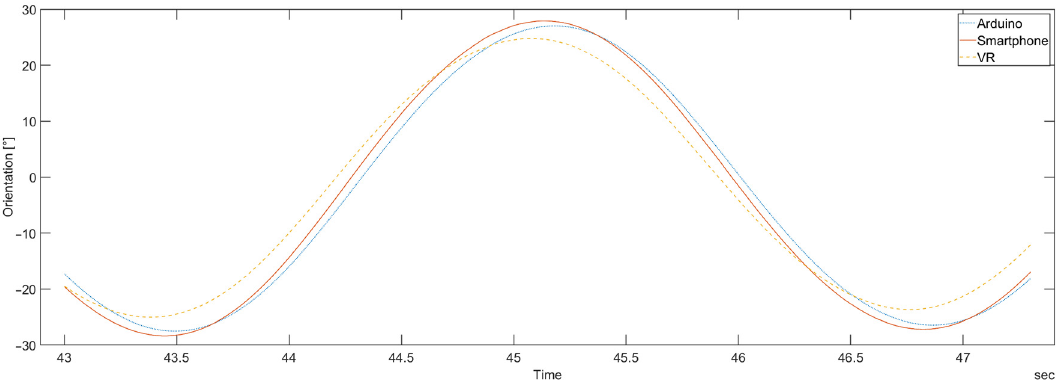
Figure 21. One period of calculated orientation for an Arduino-based device (the ICMAK sensor), a smartphone (the iPhone), and the VR device.